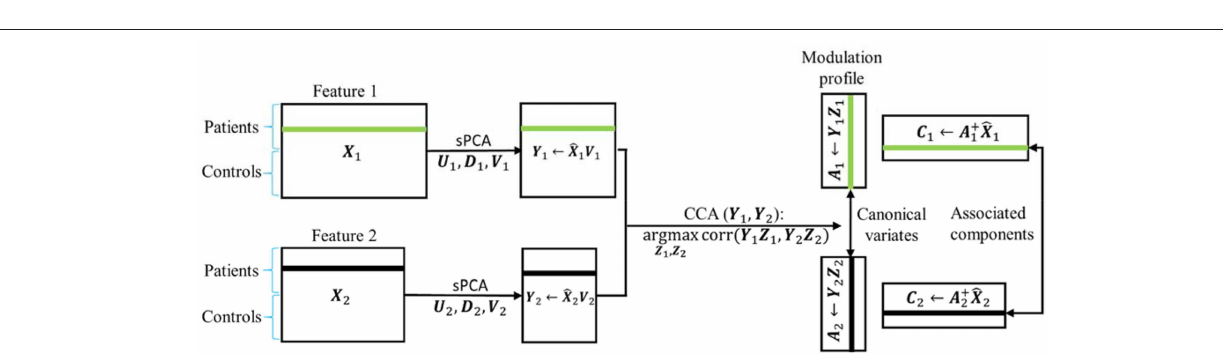
X r = U r D r V T r with r = 1,2, is the data matrix of the two modalities obtained b